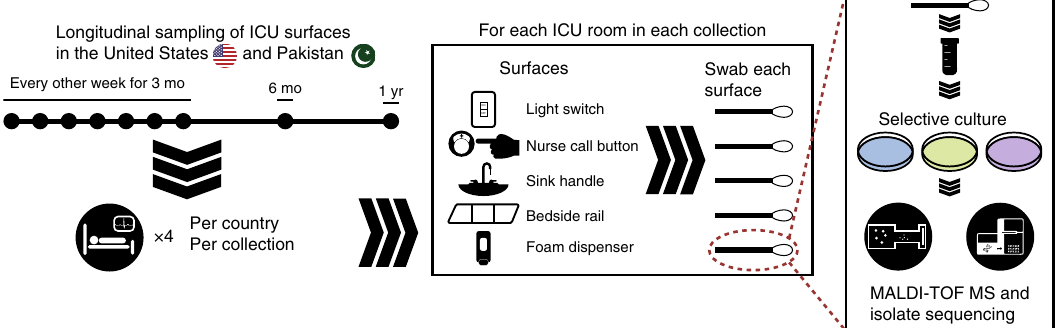
Fig. 1 Overview of sample collection and processing. Samples were collected from surfaces longitudinally over the course of 1 year from PAK-H ICU and USA-H ICU. Four rooms from each ICU were chosen for sampling and fi ve surfaces within each room were surveyed for every collection time. Bacteria were cultured from the collection swabs, identi fi ed by MALDI-TOF MS, and then whole-genome